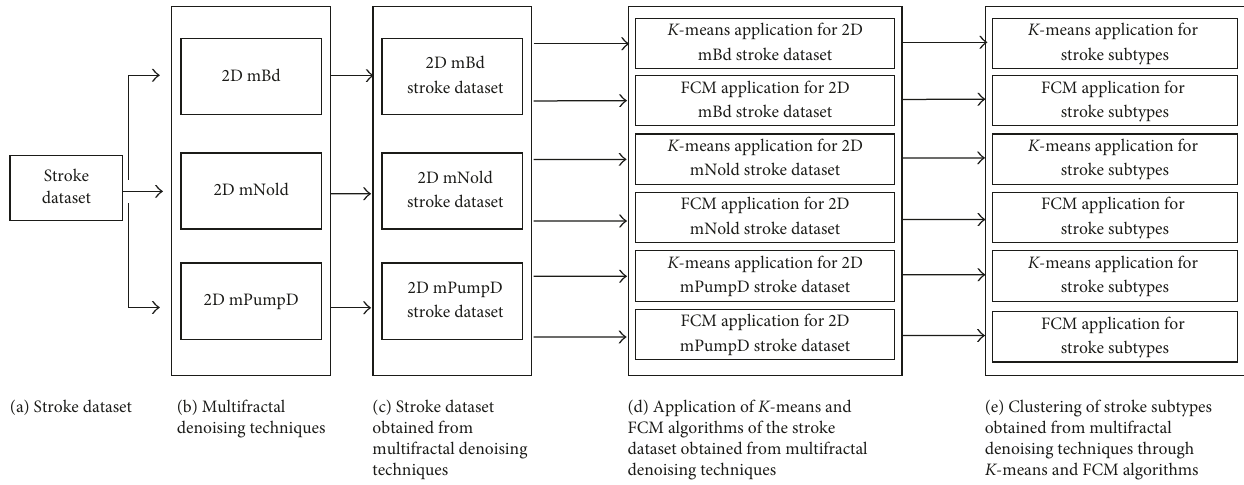
Figure 4: Clustering of the stroke dataset with the application of multifractal denoising techniques through 𝐾 -means and FCM